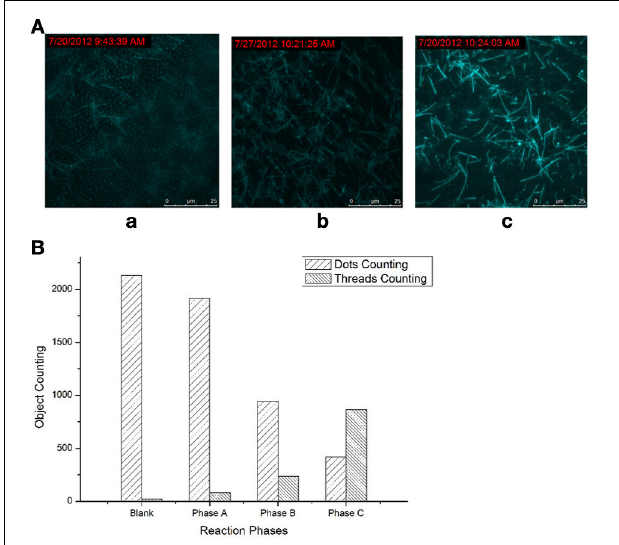
Figure 1 | Products of the molecular machine at three phases. (A) TIRFM visualization: (a) Phase A, simple RCA (rolling-circle amplification); (b) Phase B, RCA cycled and amplified by TDP (target-displacement polymerization); (c) Phase C, the full molecular machine, RCA cycled by TDP which was further cycled and amplified by NPC (nicking-polymerization cycle). (B) Counting results of the dots and thread-like